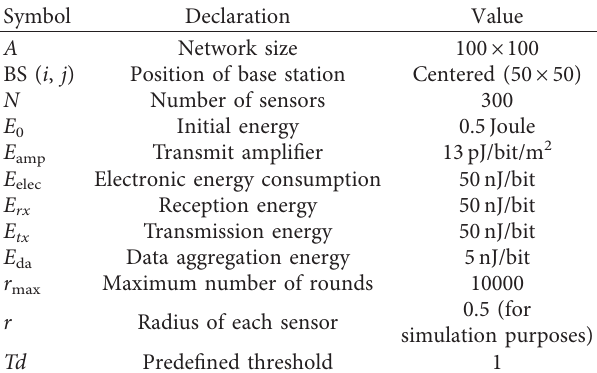
Table 2: Simulation parameters.